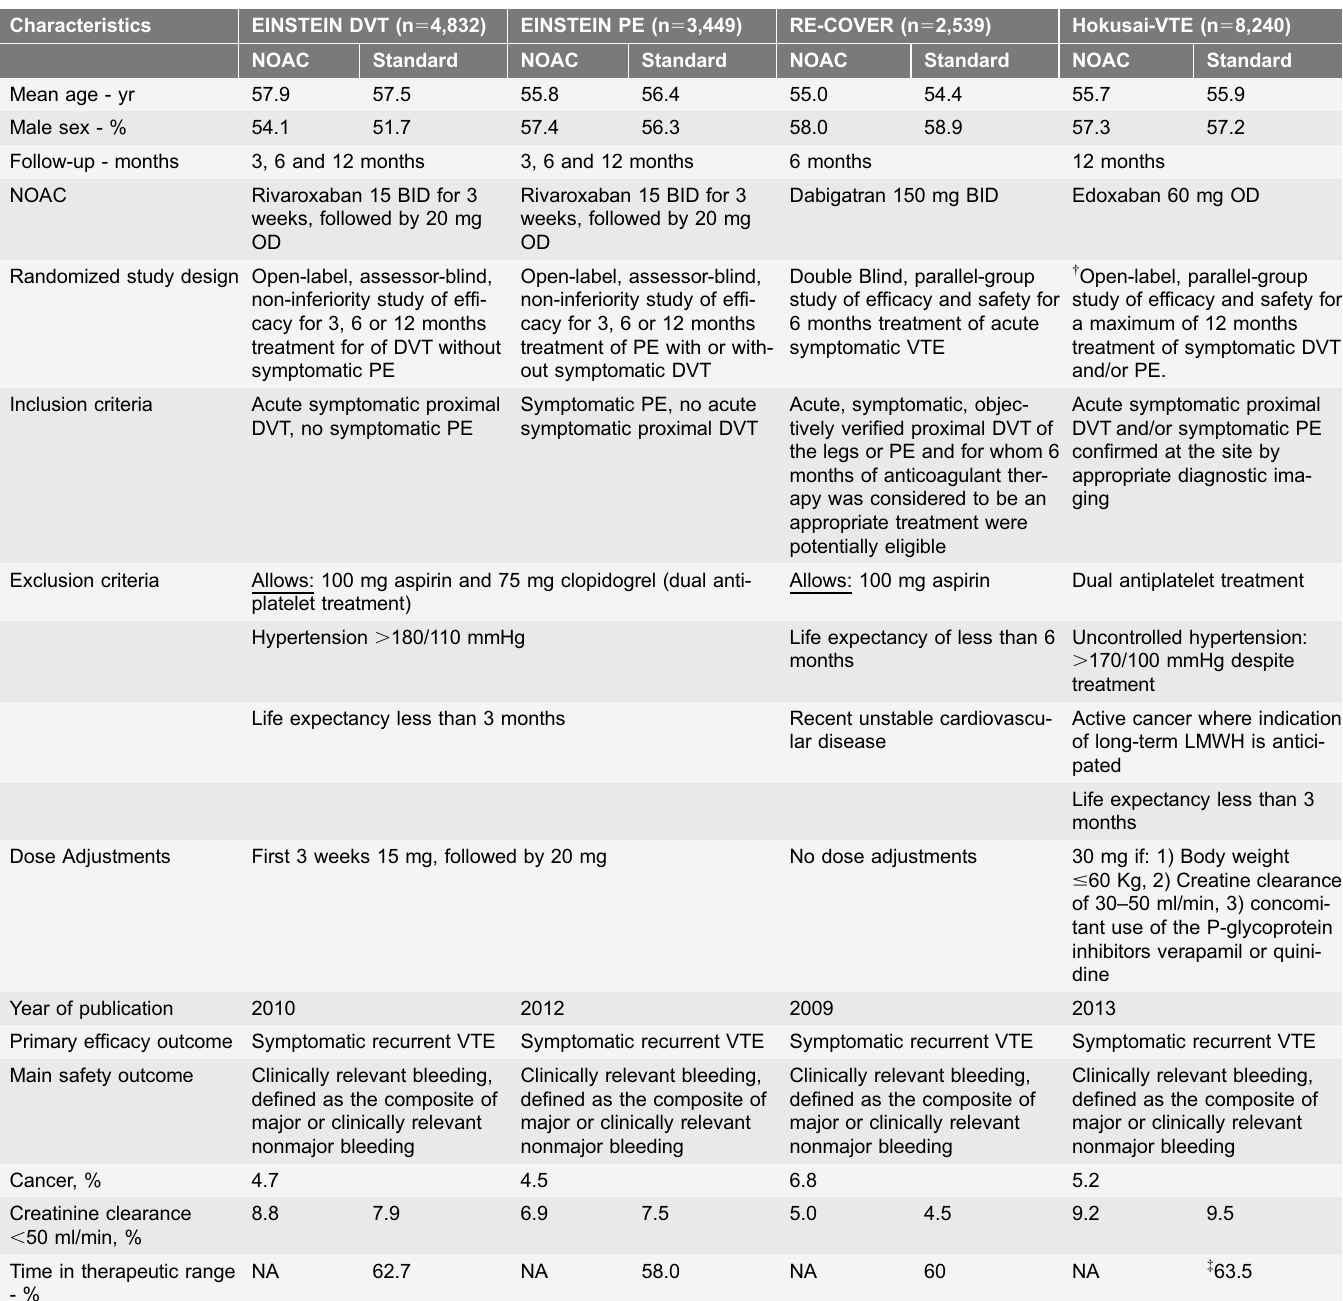
Table 1. Selected patient characteristics of the included randomized